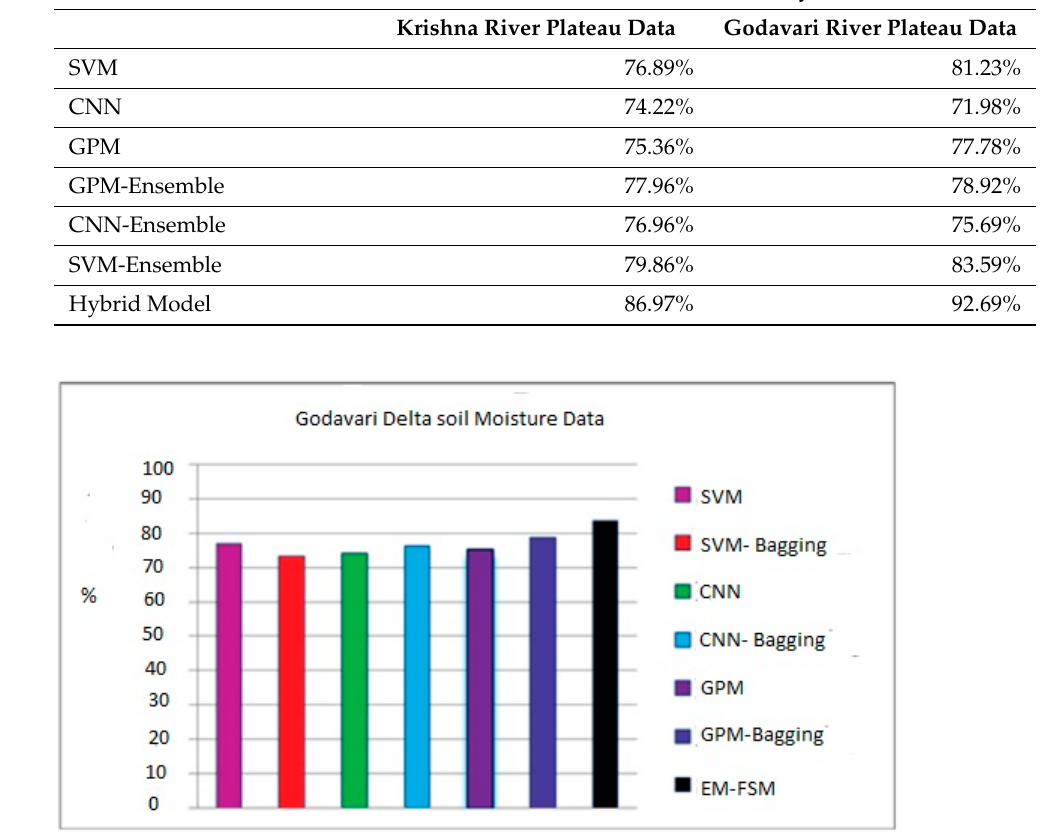
Table 2. Prediction accuracy of various classi fi ers.